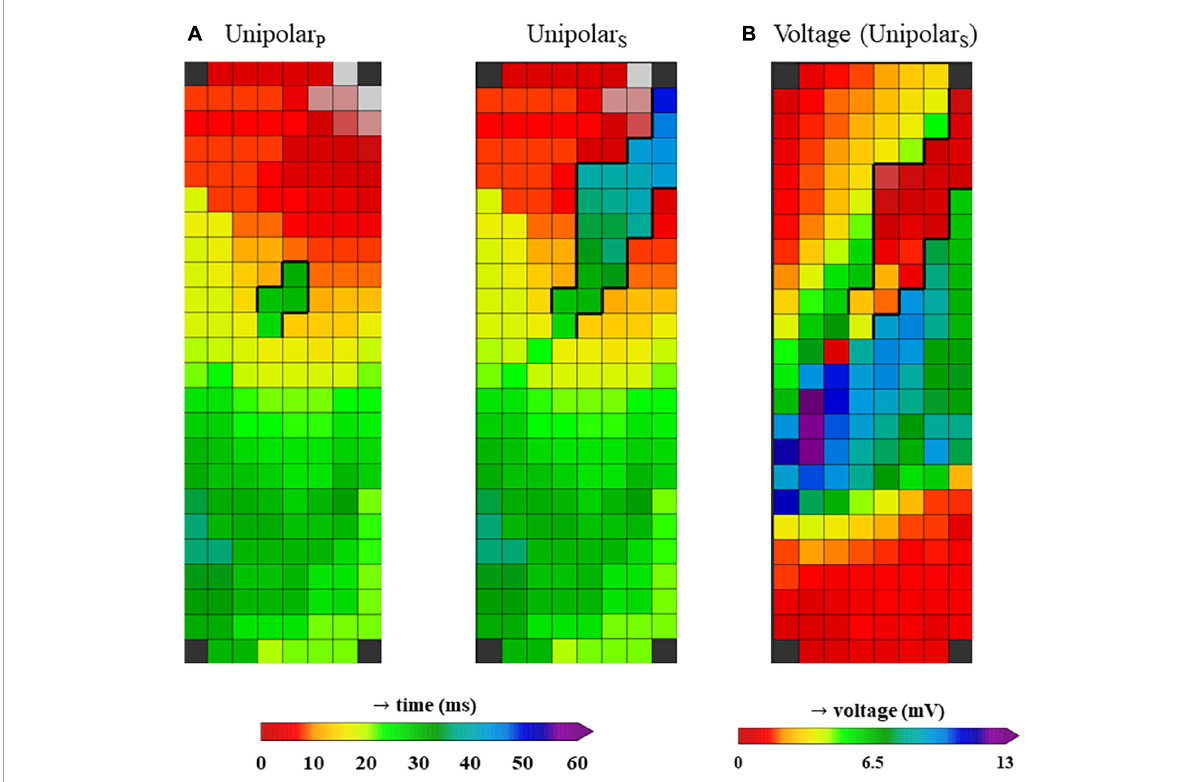
FIGURE2 (A) Two activation maps from the same patient, constructed using unipolar LATs from only primary deflections (unipolar P , left) and a combination of primary deflections in case of single potentials and secondary deflections in case of double or fractionated potentials (unipolar S , right). (B) Voltage map from the same patient, using the voltages from unipolar primary deflections and the secondary deflections with the largest peak-to-peak amplitude (in case more than one secondary deflection was present).